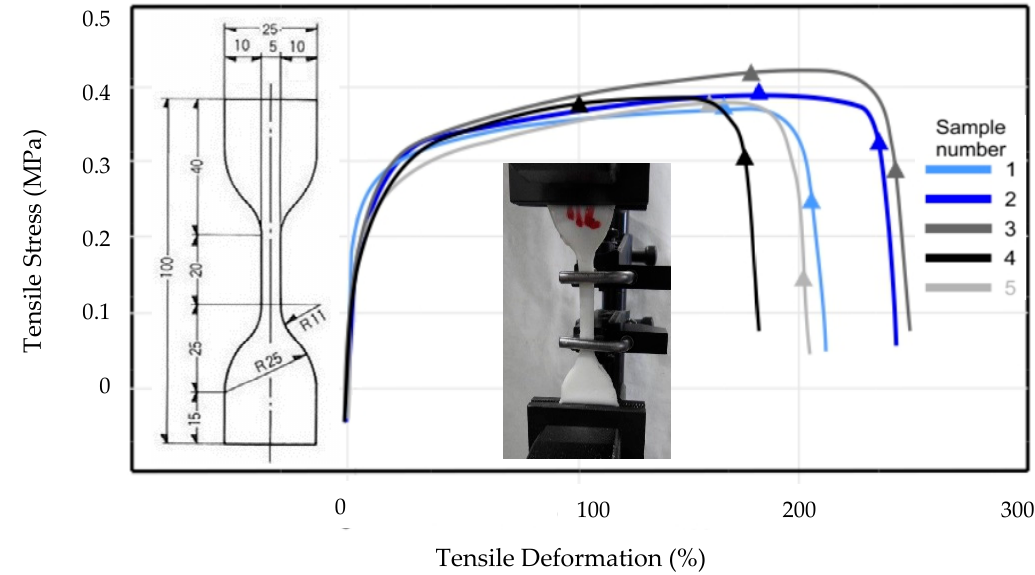
Figure 3. The tensile stress-deformation curves as a function of deformation in axial tensile test of resin 1, Table 2 (5 samples - based on thixotropic acrylic) according to PN-EN ISO 37 [16]. The obtained results of the axial tensile test for the analysed resins according to PN-EN ISO 37 [16] are presented in Table 2. Table 2. Results from the axial tensile test for the analysed resins according to PN-EN ISO 37 [16]. Tested Specimen Resin